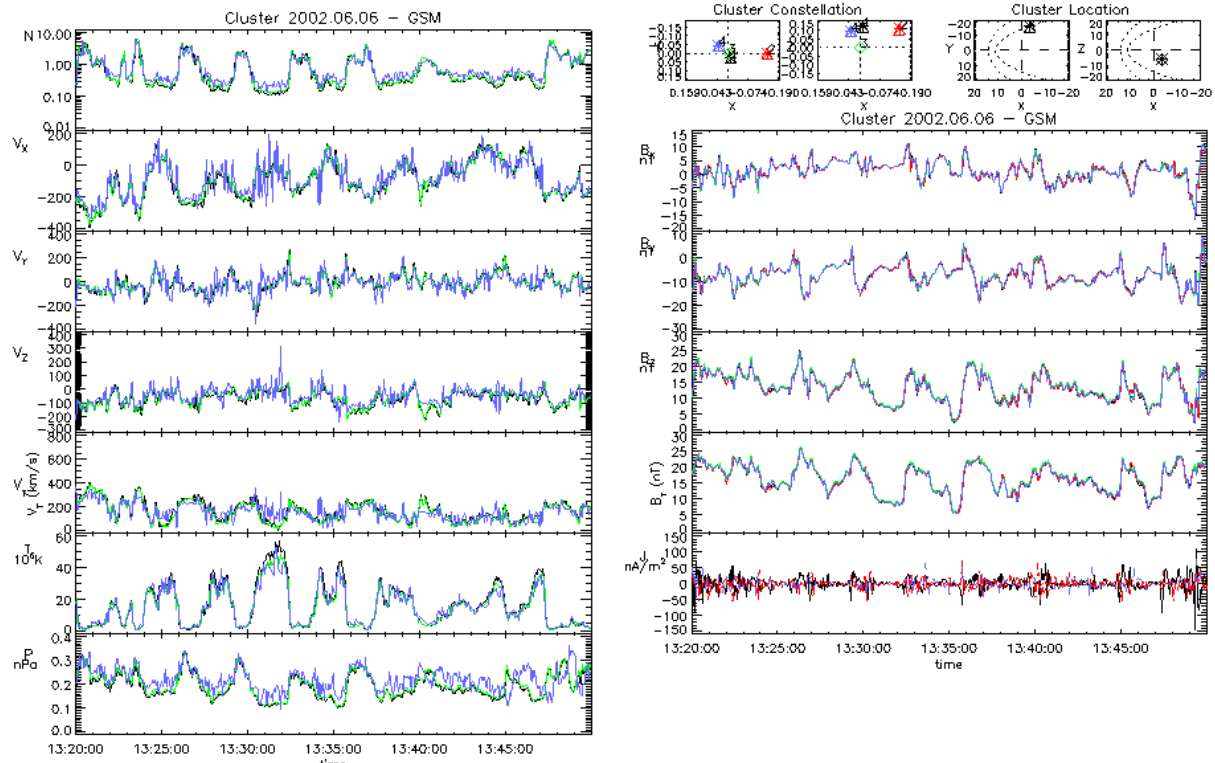
Fig. 1. Cluster plasma (left) and magnetic field (right) observations for Event 3 in GSM coordinates, which was used to determine the MSH and MSP values for the local MHD model. In order, the four spacecrafts are represented by black, red, green, and blue colors. The left panel, from the top, displays ion density, three velocity components, total velocity, plasma temperature and pressure. The right panel, from the top, displays three magnetic field components, total magnetic field, and current density. The four smaller panels on the top right hand corner show the Cluster constellation and location with the asterisk and diamond representing the beginning and ending of the interval, respectively.